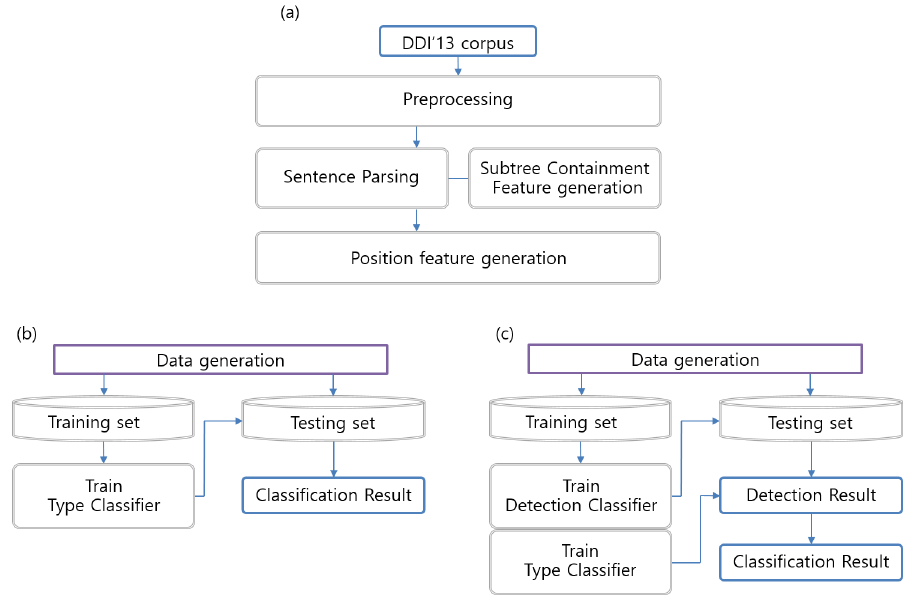
Fig 1. Overall system architecture. We implemented both the one-stage and the two-stage method. (a) Data generation part. (b) One-stage method. Five-class type classifier for the one-stage method. (c) Two-stage method. The DDI detection classifier distinguishes positive DDI instances from negative instances. The DDI type classifier receives the predicted positive instances from the detection classifier as a testing set.